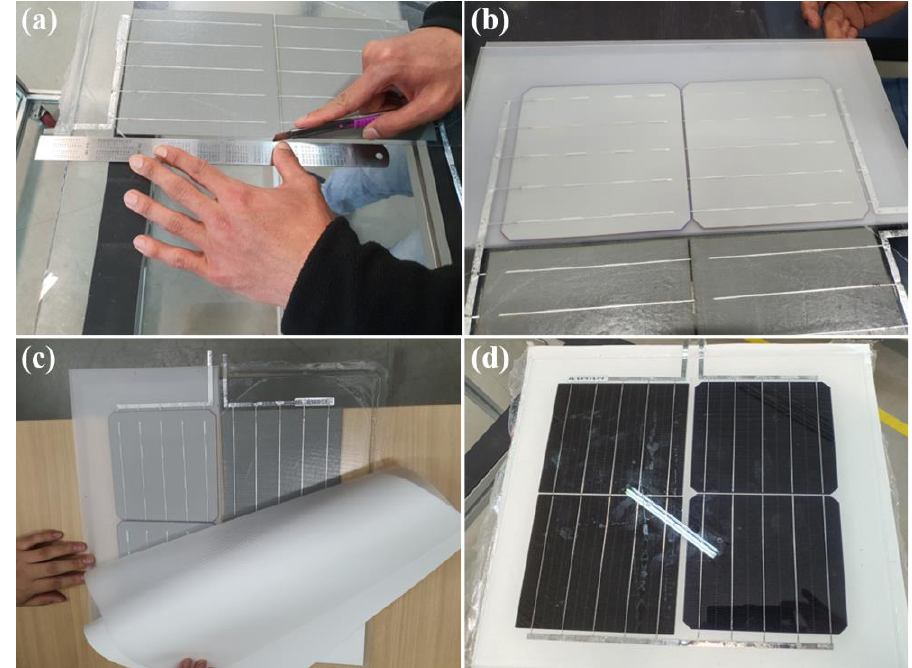
Figure 5. Sample making process for a module repaired by cell replacement.